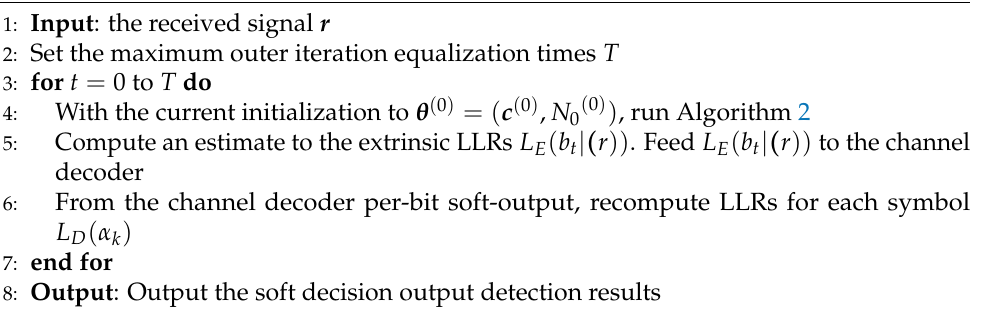
Algorithm 3 The EMLVA blind turbo equalizer